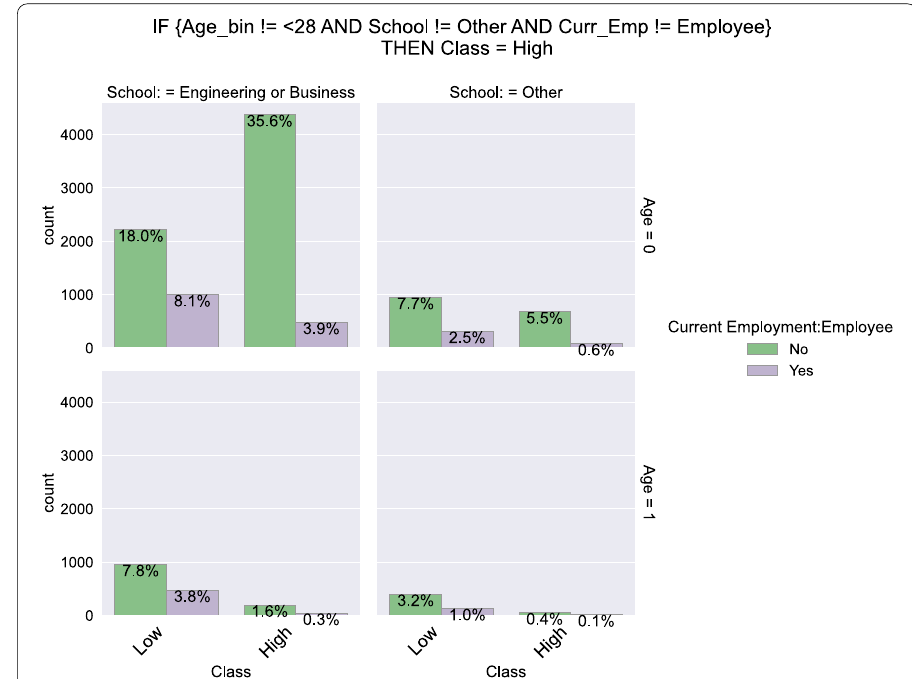
Fig. 18 Visualization of the first contrast pattern of Age, School, and Current Employment variables in bar plot